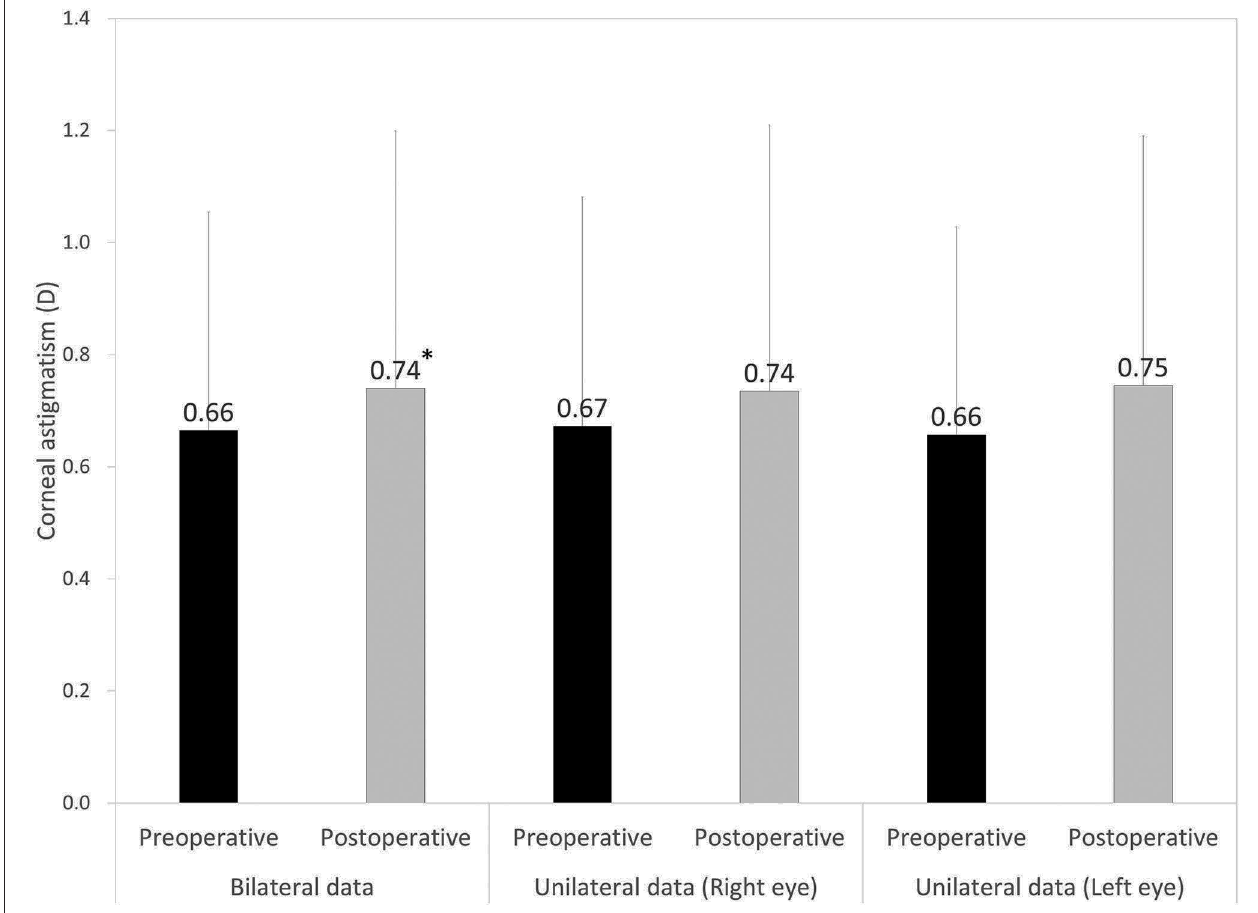
FIGURE 1 | Graph showing the magnitude of corneal astigmatism preoperatively and 3 months postoperatively using bilateral and unilateral data. The bar represents standard deviation. D, diopters. *Indicates statistical